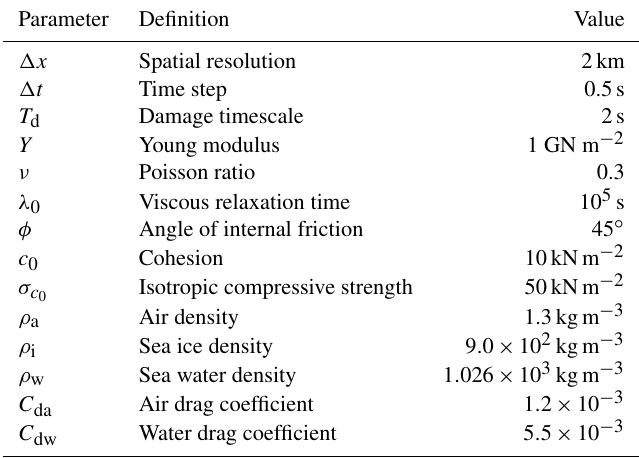
Table 2. Default model